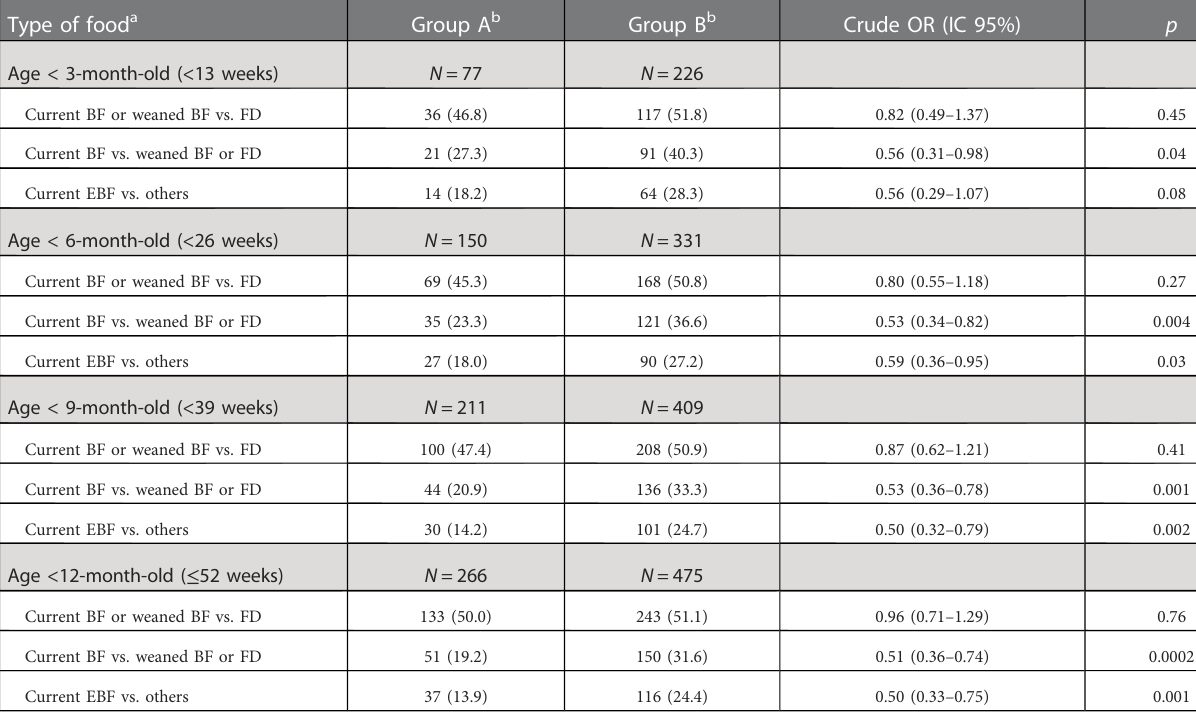
TABLE 3 Comparison of food since birthday between infected children and non-infected children by age-group - Univariate